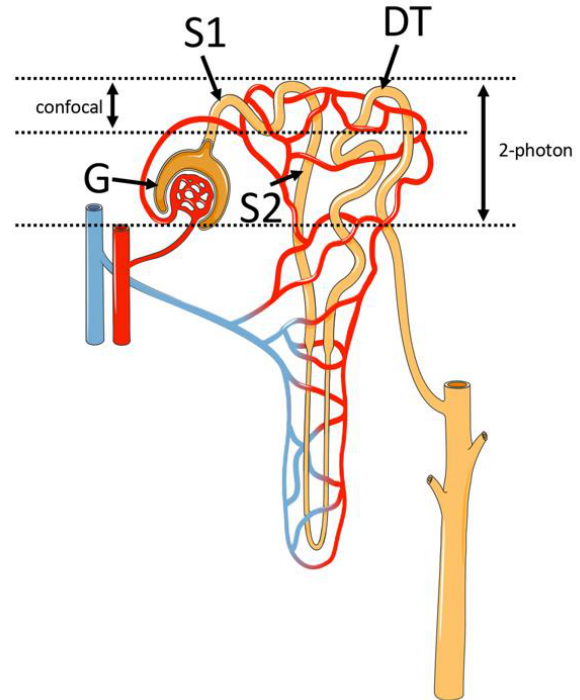
Figure 2. Schematic representation of the renal structures identified with 2PM. The nephron segments Error in Figure/Table that are visible with confocal and 2PM are shown. As indicated by the vertical arrows, 2PM allows the renal structures to be imaged about 3 times deeper compared to confocal microscopy. G = glomerulus; S1 = S1 proximal convoluted tubule; S2 = S2 proximal convoluted tubule; DT = distal tubule. This figure was drawn adapting the vector image from the Servier Medical Art bank (http://smart.servier. com/; last accessed on 22 February